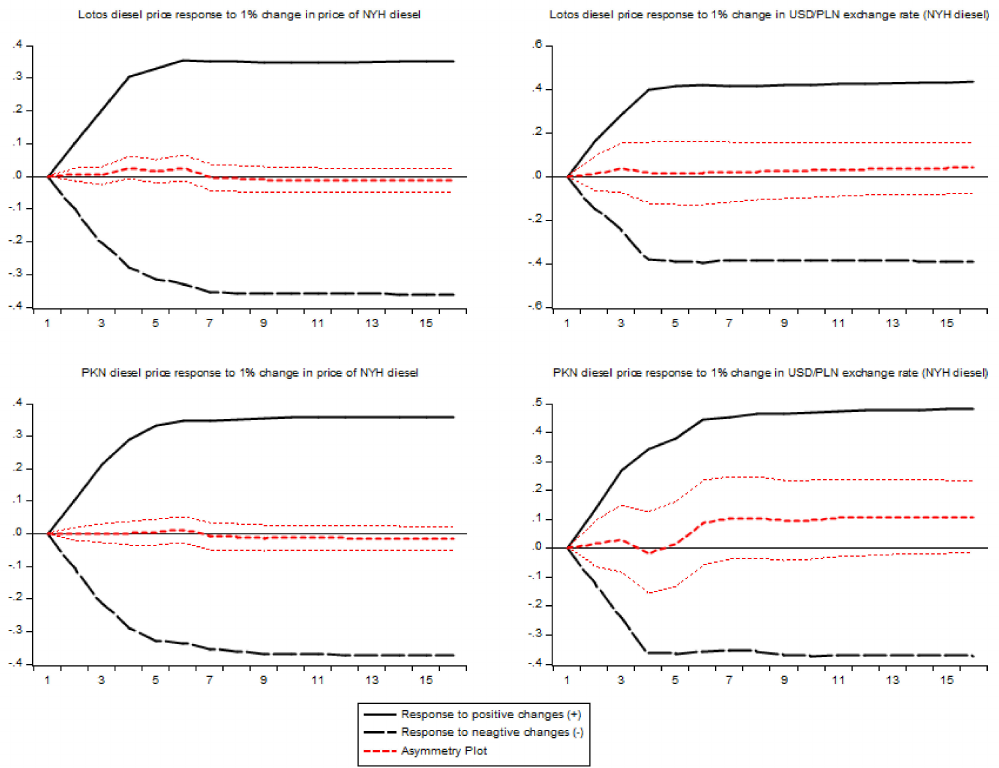
Figure 8. Dynamic multipliers—whole sample, wholesale diesel, and